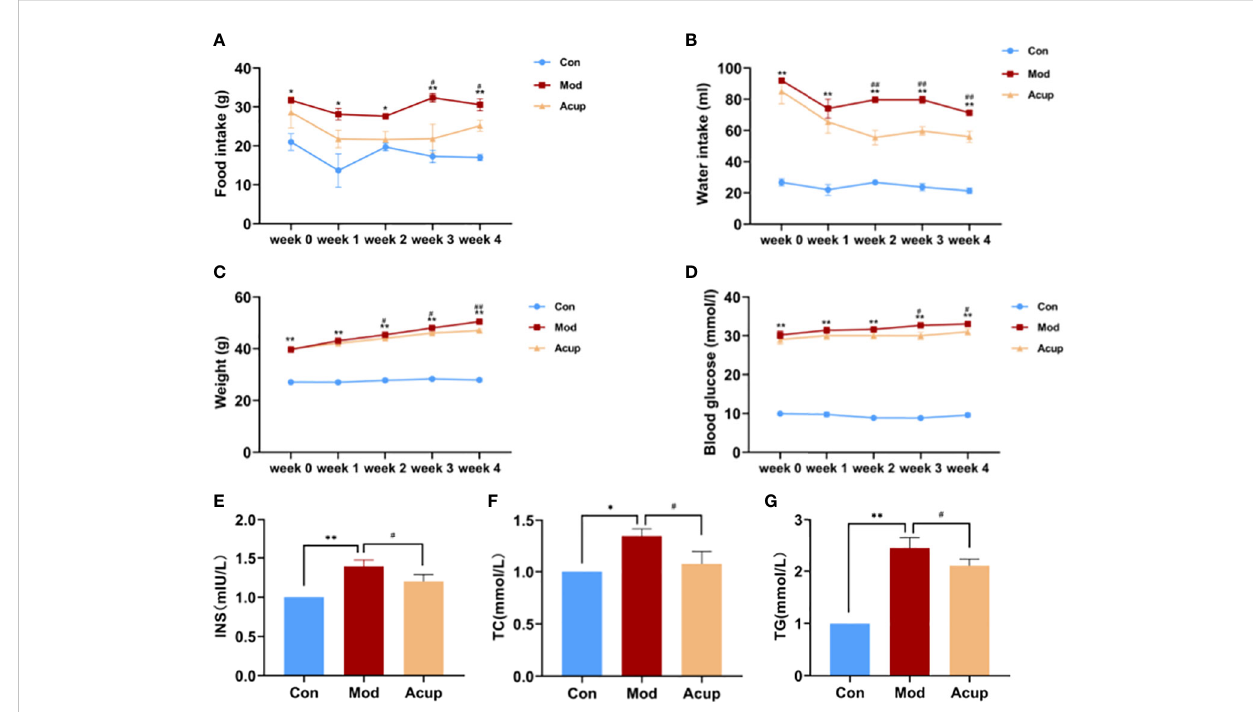
FIGURE 2 Effects of electroacupuncture on general indicators in db/db mice. (A) Food intake, (B) Water intake, (C) Weight and (D) Blood glucose changes before and after electroacupuncture treatment. (E) INS, (F) TC and (G) TG levels in mice serum were analyzed using Elisa kit. Data are expressed as means ± SEM. Mod vs Con, # p < 0.05, ## p < 0.01; Acup vs Mod, * p < 0.05, ** p <